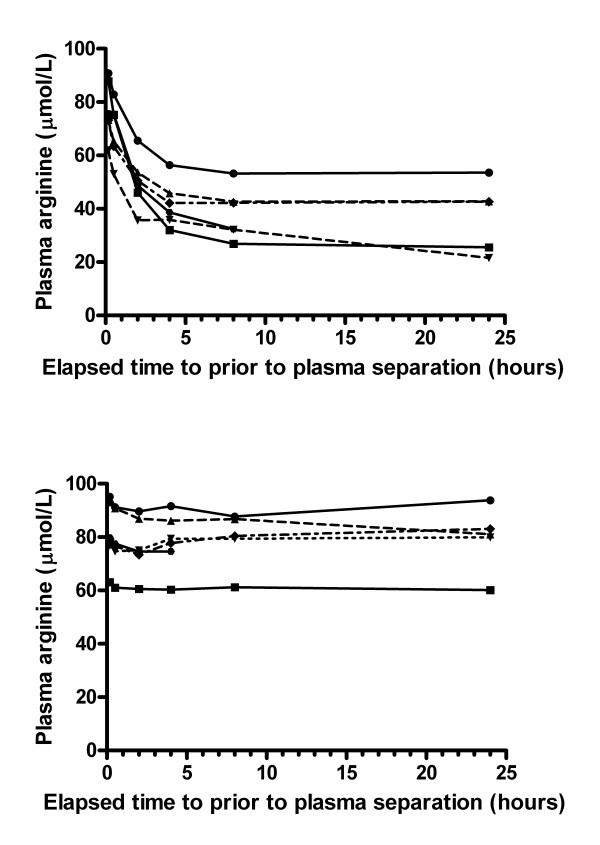
Plasma arginine time profile at room temperature and on ice. Each curve represents an individual subject. Figure 1a depicts results from whole blood stored at room temperature (25°C). Figure 1b depicts results from aliquots of the same blood samples which were stored in an ice slurry.